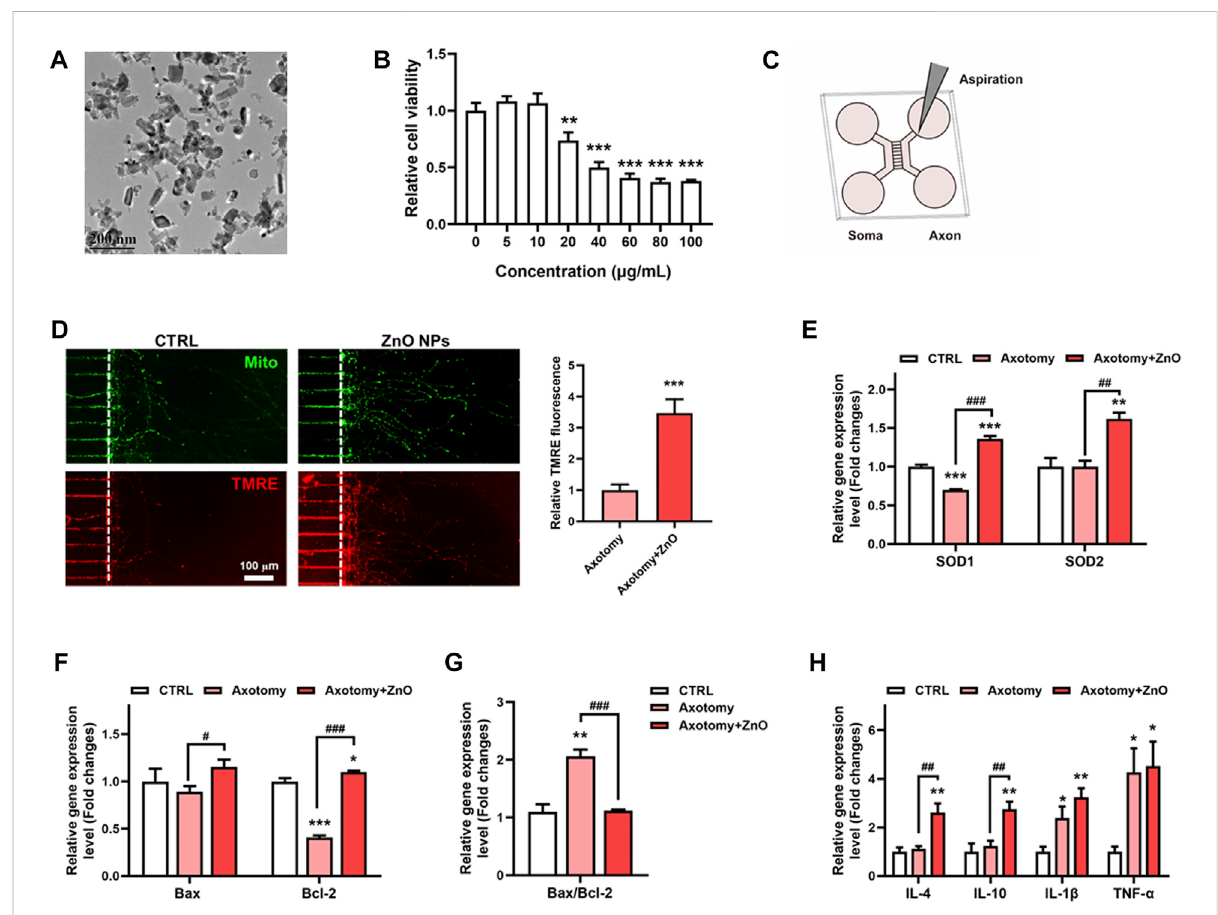
ZnO NPs exhibit a protective role on neurons after axotomy. (A) The morphology and size of ZnO NPs were characterized using TEM. (B) The cellviabilityassayofneuronsafterZnONPstreatmentwithvariousconcentrationsfor24 h. (C) Schematicdiagramofconstructingan invitro neuron axotomy model using micro fl uidic chip. (D) After aspiration, ZnO NPs were treated for 24 h, MitoTracker and TMRE dyes were used to label mitochondria and functional mitochondria respectively, and the TMRE fl uorescence intensity in axon regeneration terminals was statistically analyzed. (E) qRT-PCR data of SOD1 and SOD2 in neurons treated axotomy with or without ZnO NPs treatment for 24 h; changes in the gene expression levels were quanti fi ed after normalization against β -actin. (F – G) qRT-PCR data of Bax and Bcl-2 in neurons treated axotomy with or without ZnO NPs treatment for 24 h; changes in the gene expression levels were quanti fi ed after normalization against β -actin, and the Bax/Bcl- 2 ratio was calculated and statistically analyzed as well. (H) qRT-PCR data of IL-4, IL-10, IL-1 β and TNF α in neurons treated axotomy with or without ZnO NPs treatment for 24 h; changes in the gene expression levels were quanti fi ed after normalization against β -actin. * p < 0.05; ** p < 0.01; *** p < 0.001 compared with the control group. # p < 0.05; ## p < 0.01; ### p < 0.001 compared with the axotomy